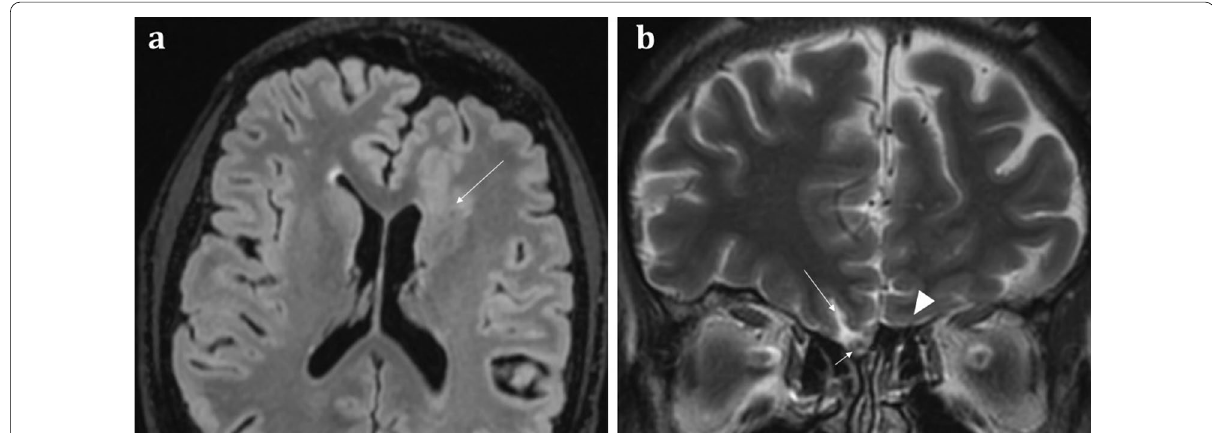
Fig. 11 51-year-old male with a history of known focal epilepsy secondary to grey matter heterotopia. Axial FLAIR sequence ( a ) demonstrates unilateral hypoplastic left cerebral hemisphere with focal subependymal grey matter heterotopia within the left frontal region (arrowed). Coronal T2WI ( b ) also demonstrates an associated ipsilateral complete absence of both the olfactory bulb and olfactory sulcus (arrowhead). In comparison, the right olfactory bulb (short arrow, b ) and olfactory sulcus (long arrow, b ) are